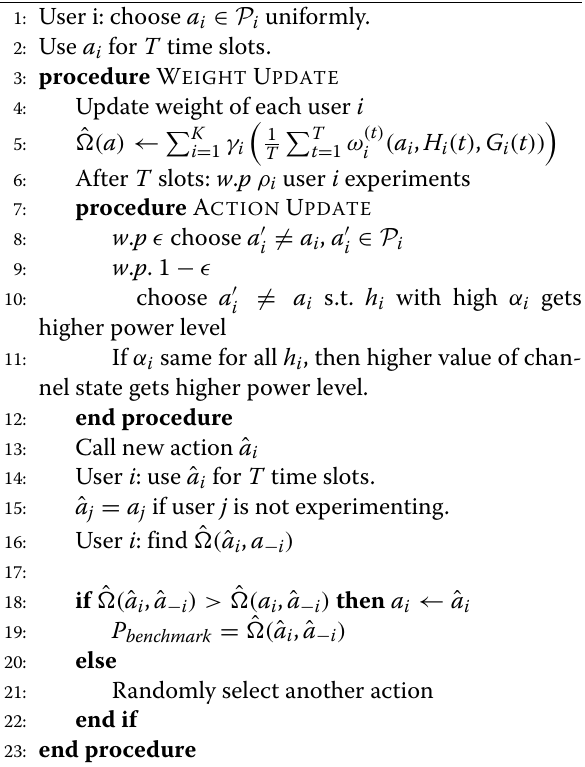
Algorithm 2 Distributed Algorithm to obtain Pareto